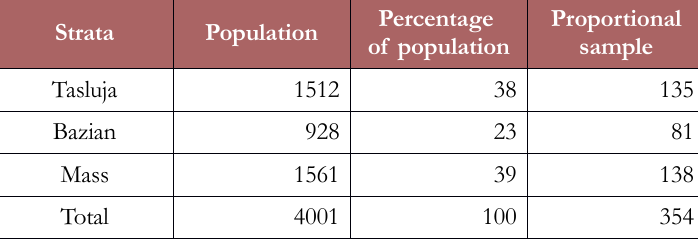
Table 1. Stratified population and